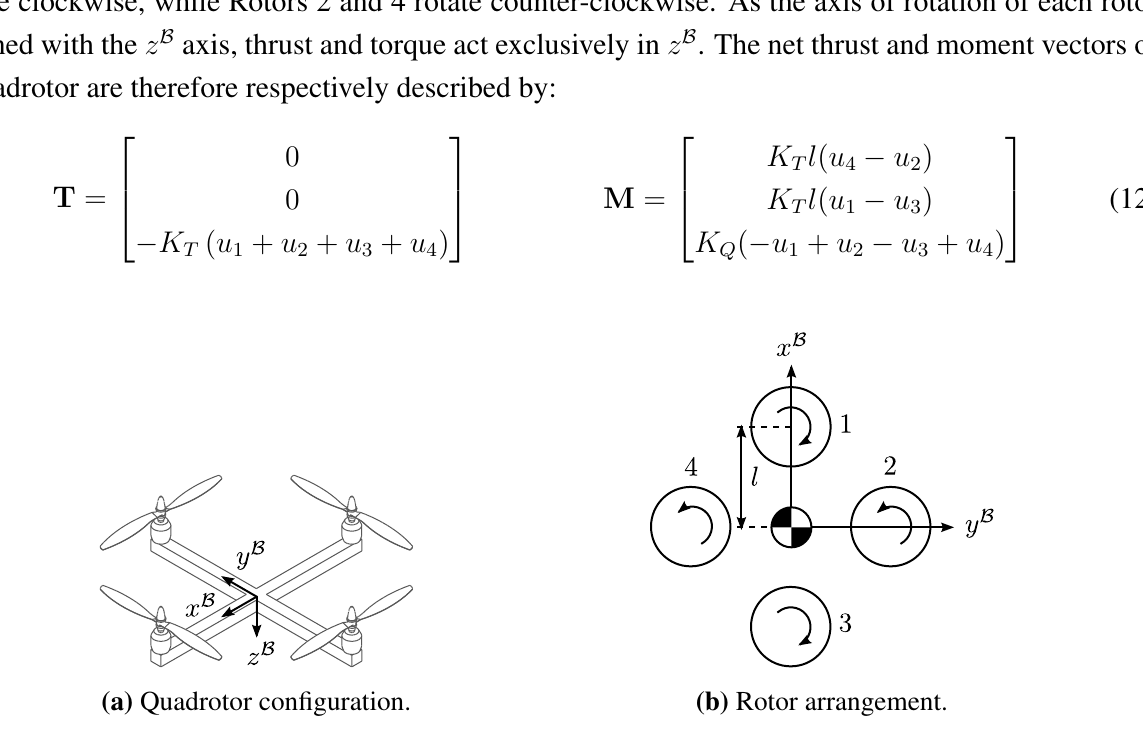
Figure 2. Quadrotor configuration and the axes’